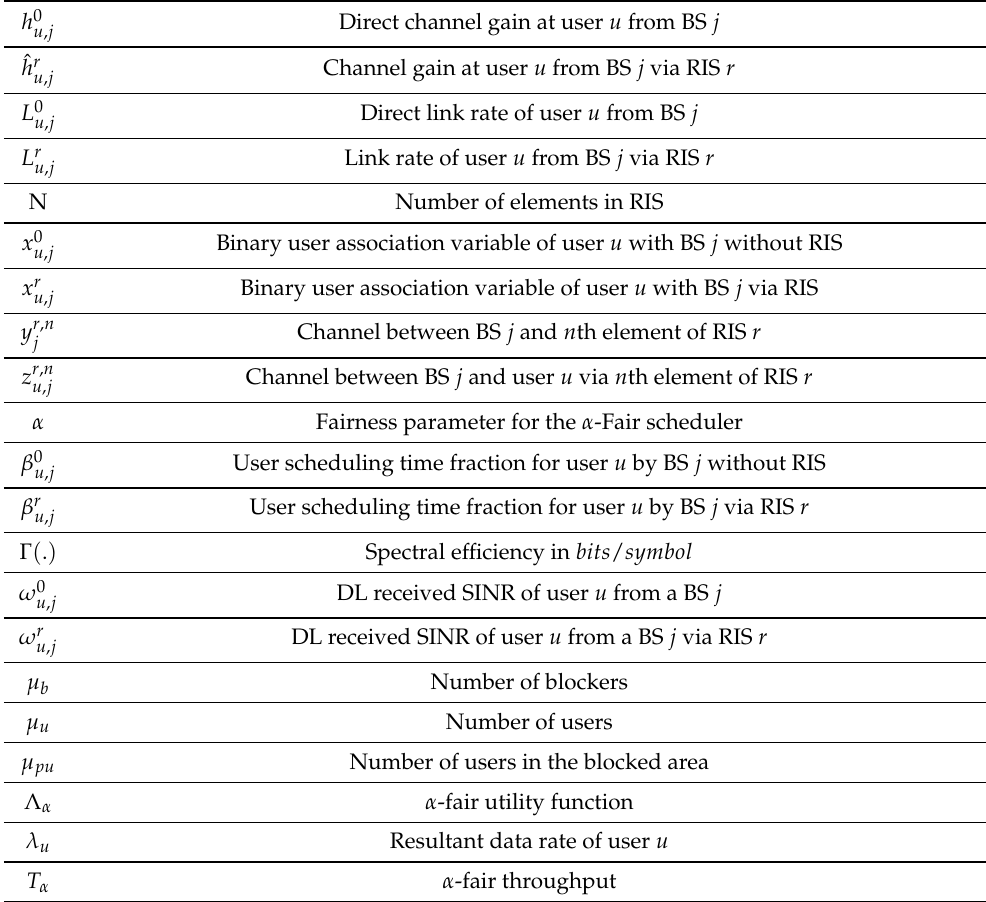
Table 1. Mathematical